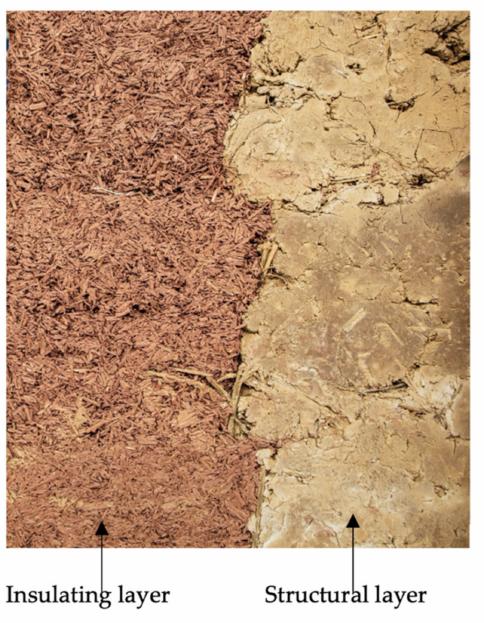
Figure 1. Photo of cob composite wall.